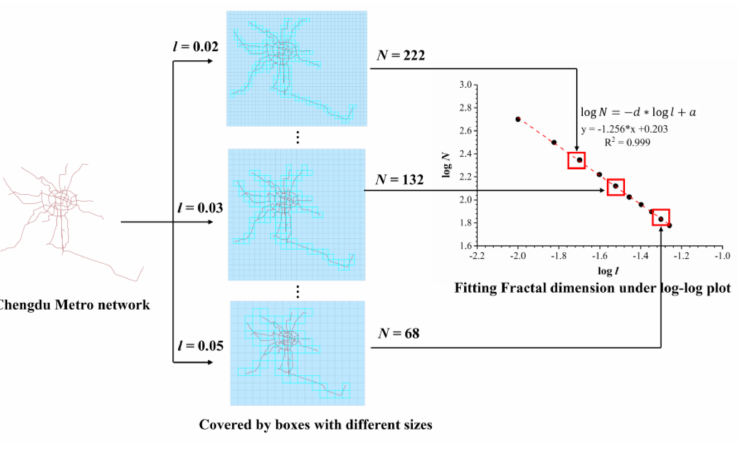
Figure 2. The whole process of calculating the box-counting fractal dimension.